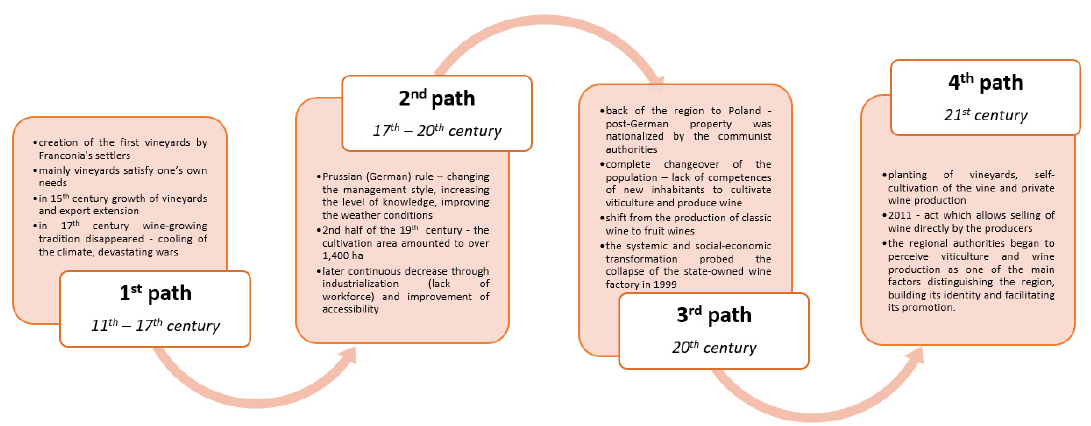
Figure 2. Historic paths of wine production development in Lubuskie region. Source: own study.